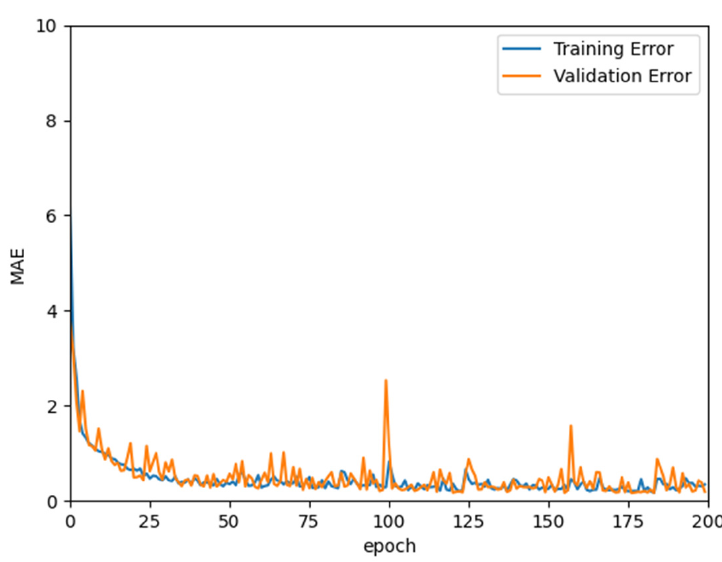
Figure 5. Mean absolute error generated by training and validation data.